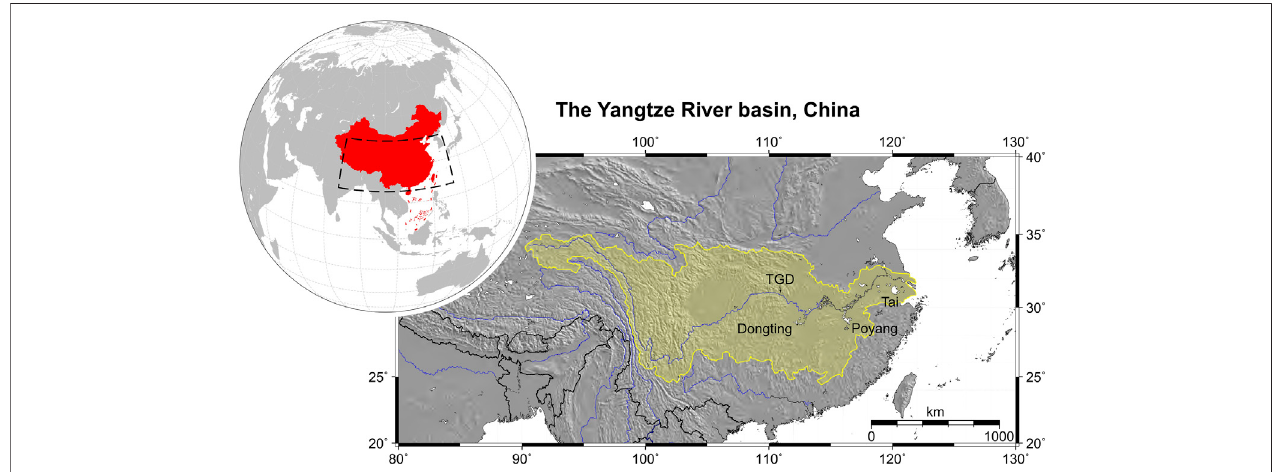
FIGURE 1 | Location map of the Yangtze River basin, China, and its main surface waters. Source: adapted from Ferreira et al.